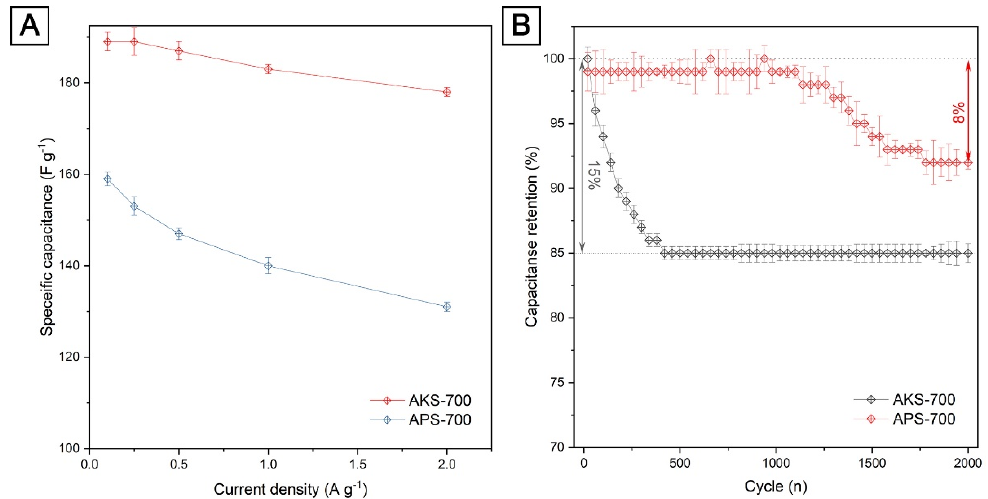
Figure 6. ( A ) The values of the specific capacitance of the electrodes measured at different current densities; ( B ) capacity retention of electrodes based on AKS-700 and APS-700 for 2000 cycles at constant current charge–discharge cycling, current density 1 A g − 1 .